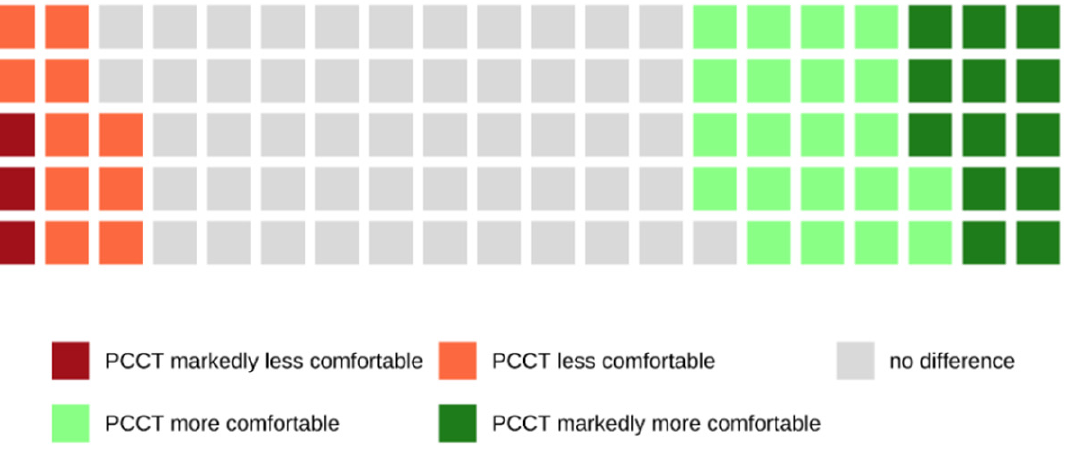
Figure 4. Waffle chart showing the comparison of both CT scanners in terms of effort to lie down and get up from the CT table. Most patients did not perceive any difference between the PCCT and the SCT (53.2%), and 33.9% of patients rated the examination with the PCCT as more or markedly more